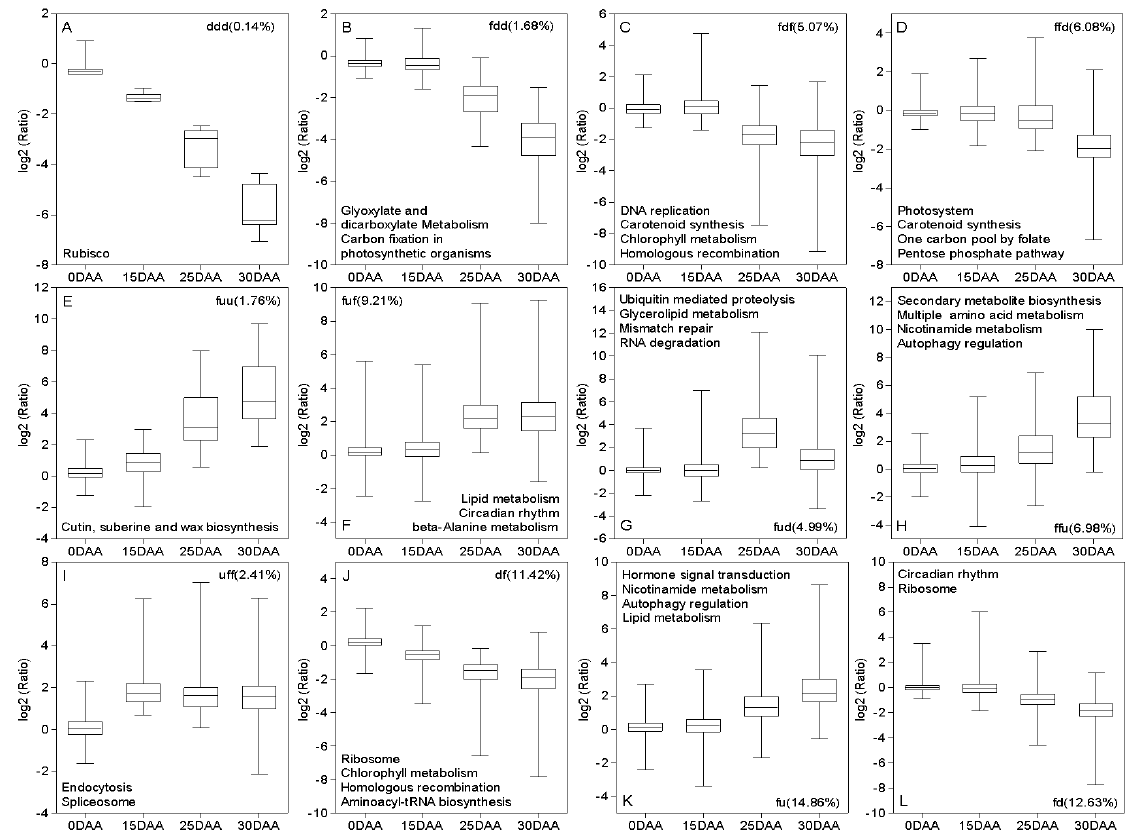
Figure 2. Classification of DEGs based on their expression dynamics. Only 12 groups ( A – L ) with enriched KEGG pathways are shown. “f” refers to the flat expression; “d” and “u” represent significant down- and up-regulation, respectively. The number in parentheses is the percentage of DEGs in each class. ( A – I ) three letters, for example, “ddd” indicate down-regulation at 0–15 DAA, 15–25 DAA and 25–30 DAA. ( J ) “df” indicates DEGs with downregulation expressions at 0–25 DAA and flat expressions at 25–30 DAA. ( K , L ) “fu” and “fd” indicate DEGs with flat expressions at 0–15 DAA and differential expressions at 15–30 DAA. The median (horizontal lines), 25th and 75th percentiles (boxes), and expression ranges (whiskers) are shown for each